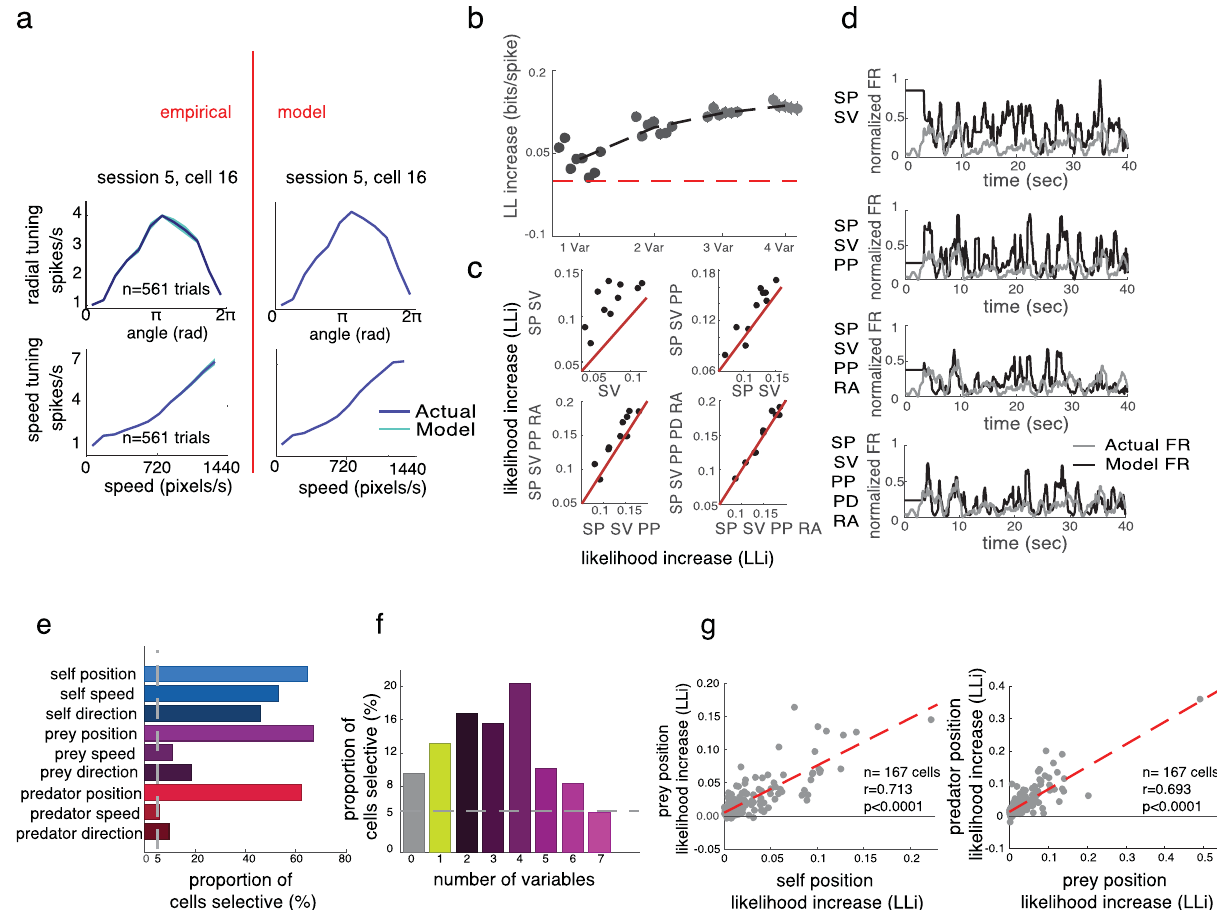
Fig. 3 World-centric tracking in dACC neurons. a Direction and speed tuning (left) and model fi t (right) for an example neuron. The error bands are connection of standard deviation in each data point. Each error bars are standard deviation for 1000 times of bootstrapping the neurons. b Proportion of neurons selective for 1, 2, 3, or 4 of the world-centric variables self position, self velocity, prey position, and relative angle between self and prey. Horizontal jitter added for clarity. Red dashed horizontal line indicates the likelihood value for mean fi ring rate model, which we treated as a zero variable model. c Likelihood increase in fi t as a function of adding additional variables. This method was used to select variables via cross-validation. The signi fi cance of tuning with respect to the variable was determined by sign-rank test between red unity line and tenfold cross-validation data points. d Example neuron showing observed fi ring rate (gray) and model predicted fi ring rate (black). The held-out data are plotted. e Proportion of neurons tuned for each possible number of task variables. Proportions do not sum to 1 because neurons may be tuned for multiple variables; results re fl ect correction for multiple comparisons. f Proportion of neurons in our sample selective for any of 7 number of variables. Most neurons are selective for multiple of the variables we test. g Correlation between log-likelihood increase (LLi) for self position vs. prey position (left) and prey position vs. predator position (right). Each dot corresponds to one neuron. Positive correlation indicates selectivity is a shared property of selective cells. The signi fi cance is obtained from Pearson correlation between LLi of speci fi c